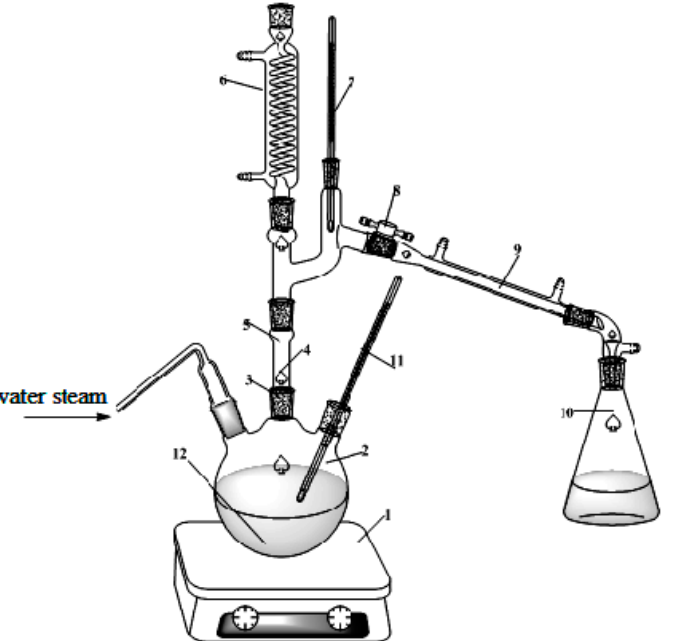
Figure 4. Laboratory diagram of the installation of thin ‐ film vapor phase extraction: 1—heater, 2— receiver, 3—metal mesh, 4—birch bark, 5—extraction column, 6—reverse refrigerator, 7 and